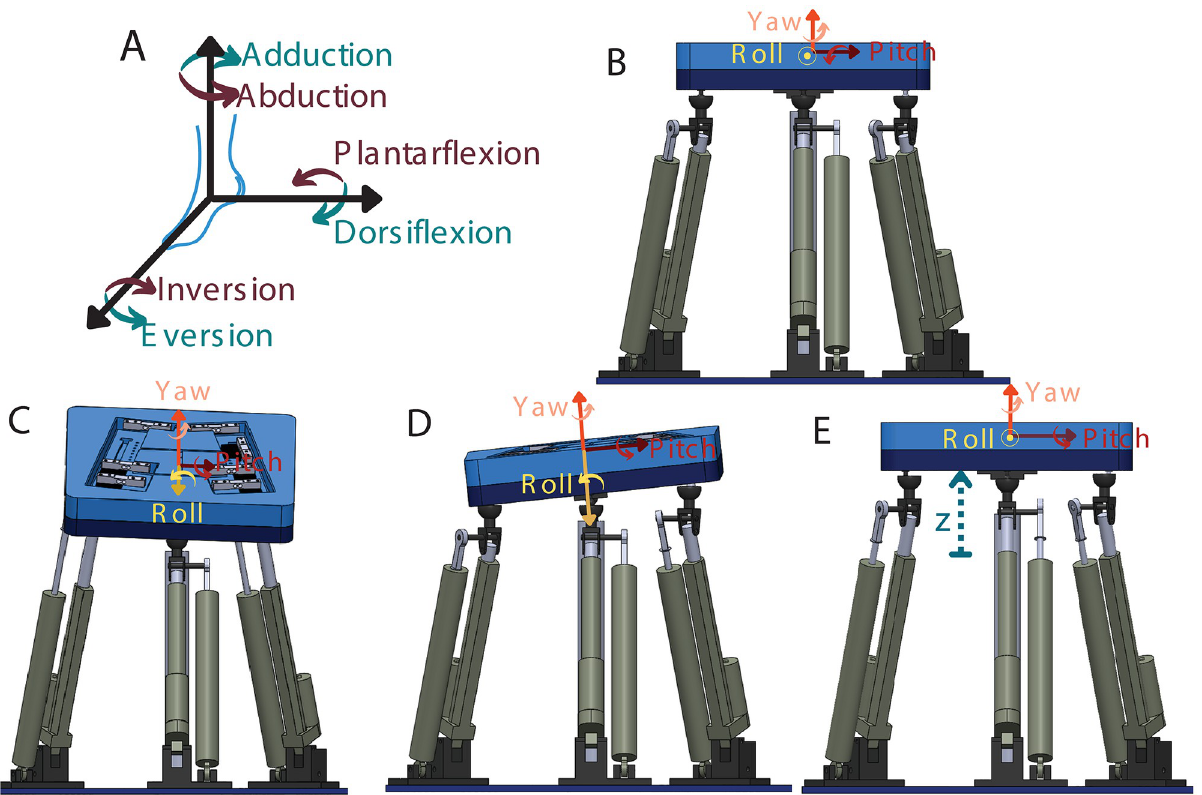
Fig 2. (A) The motions of human ankle joint (B) The robotic platform in static condition (C) Rotational motion in roll direction (D) Rotational motion in pitch direction (E) Linear motion in z